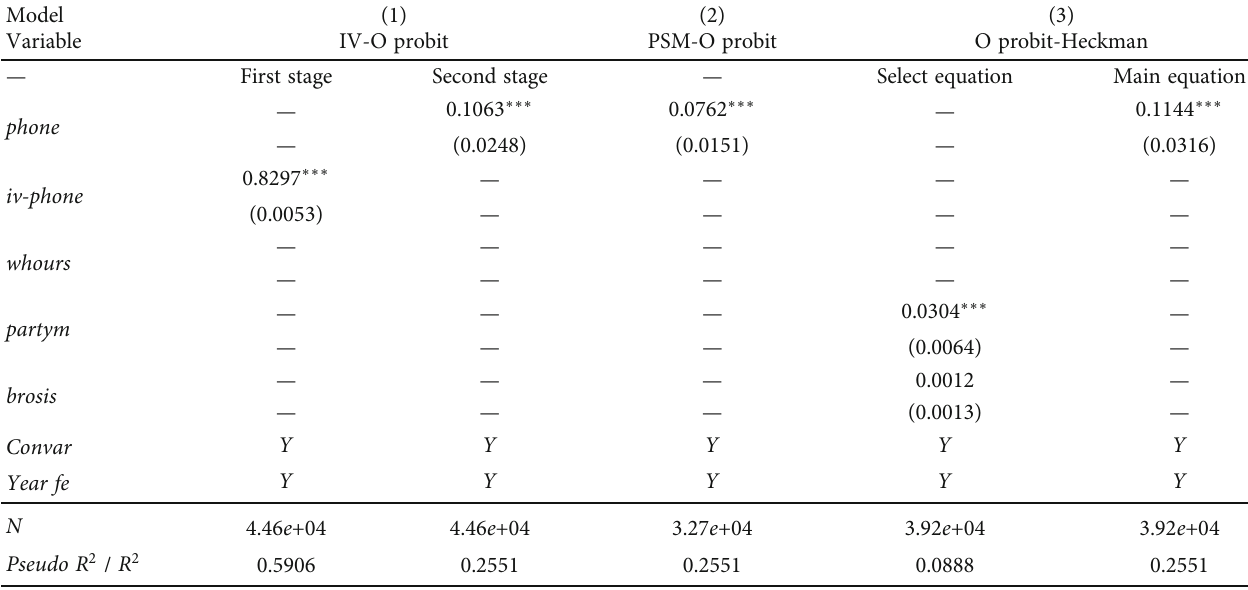
Table 6: The results of the IV-O probit, PSM-O probit, and O-probit-Heckman